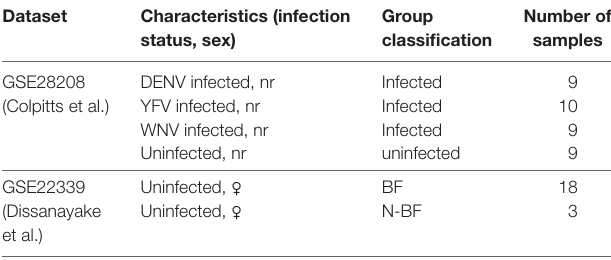
TaBle 1 | Description of A. aegypti studies used in the integrative